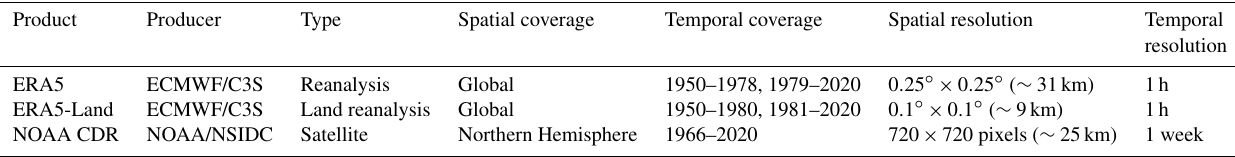
Table 1. Description of the snow products used in the study.